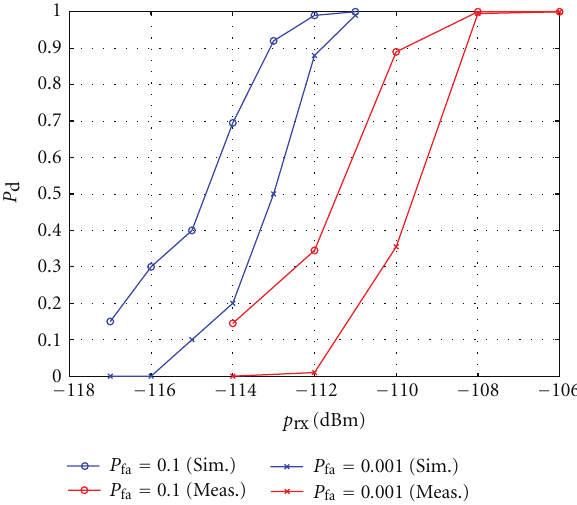
Figure 11: Simulation and measurement results for DTMB ( t sense = 20ms).